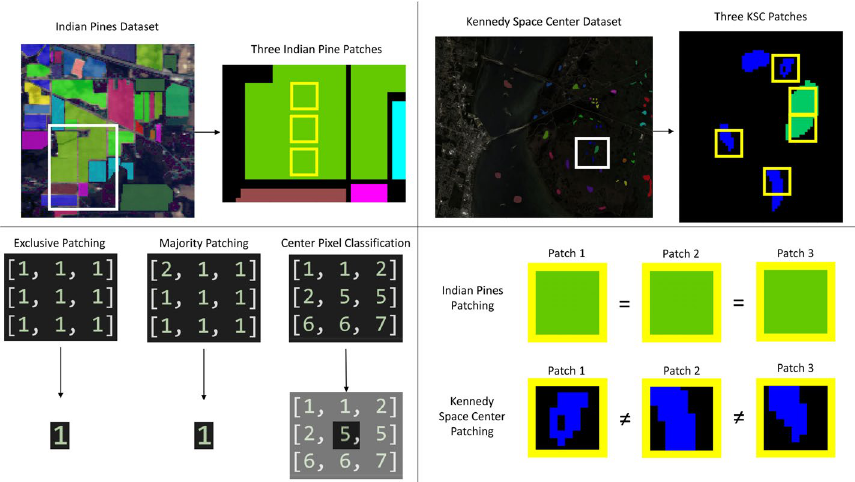
Fig. 1 The top left shows a zoomed-in area of the Indian Pines dataset with three example patches created during the patching process with the same center pixel class. The top right shows a zoomed-in area of the Kennedy Space Center dataset with five example patches. The bottom right shows the three types of patching (1) Exclusive patching takes a patch of n x n pixels and reduces the size of the dataset by downsizing the patch into one pixel if all classes in the patch match, similar to convolution. (2) Similar to exclusive patching, majority patching will downsize the patch into one pixel based on the most popular class in that patch. Both exclusive and majority patching are not used in our experiments and other works due to the already small number of labeled pixels. However, we include them as they could be used in future datasets which have potentially millions of labeled pixels. (3) Center pixel creates a n x n patch for each pixel that contains all the neighborhood information of that pixel as input into the CNN. Then it classifies the center pixel in each patch. Farmland datasets like Indian Pines have better neighborhood information than a diffused forest and therefore benefit more heavily from center pixel classification. Datasets like Kennedy Space Center have less useful neighborhood information and CPC has little impact on overall test accuracy [11] as shown in Tables 5 and 7. The bottom right shows how the three patches with the same center pixel class from the Indian Pines have identical neighbors, this shows the high value of the neighborhood information, therefore patching would be a useful step to improve semantic segmentation accuracy. However, in contrast, the patches in the Kennedy Space Center dataset do not have similar-looking neighbors and therefore the neighborhood information is not as